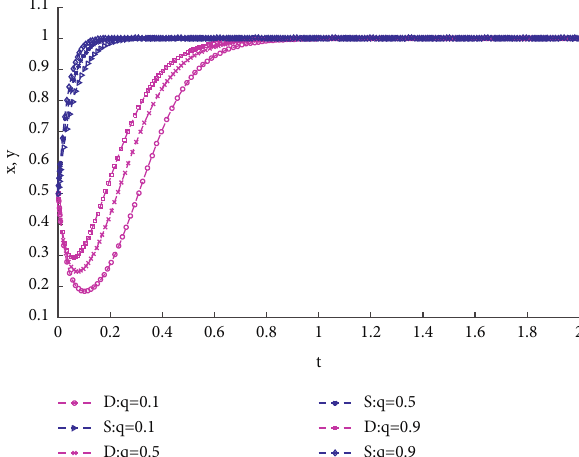
Figure 2: Evolutionary results of changes in synergy among multiple service